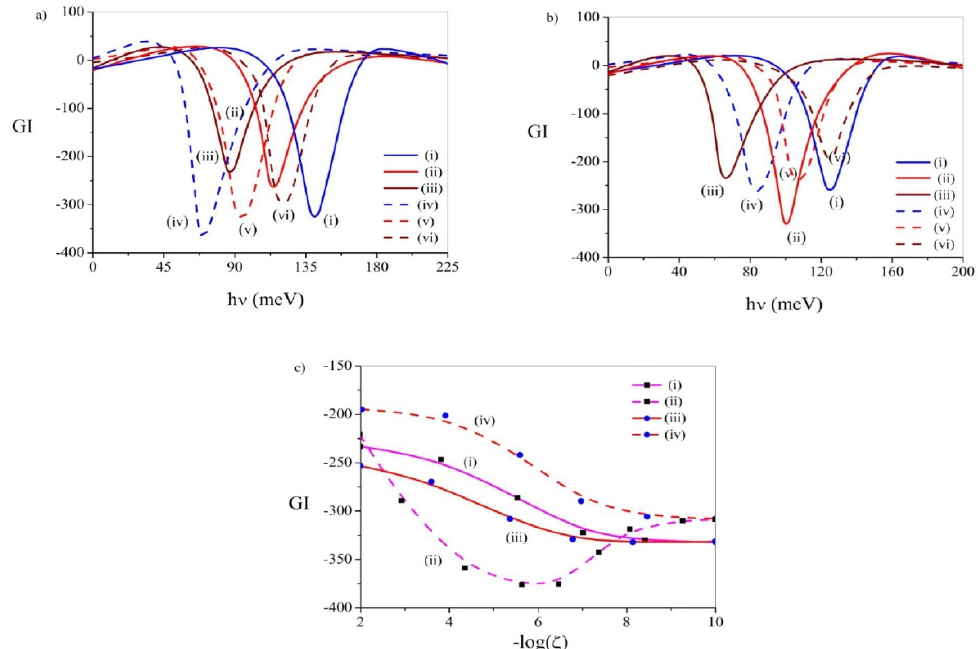
Figure 17. GI vs. h υ diagrams with ( a ) OPA and ( b ) EPA. In these diagrams (i) ADWN and ζ = 10 − 10 , (ii) ADWN and ζ = 10 − 6 , (iii) ADWN and ζ = 10 − 2 , (iv) MLWN and ζ = 10 − 10 , (v) MLWN and ζ = 10 − 6 , (vi) MLWN and ζ = 10 − 2 . ( c ) Depiction of GI peak vs. − log( ζ ): (i) with ADWN and OPA, (ii) with ADWN and EPA, (iii) with MLWN and OPA and (iv) with MLWN and EPA.